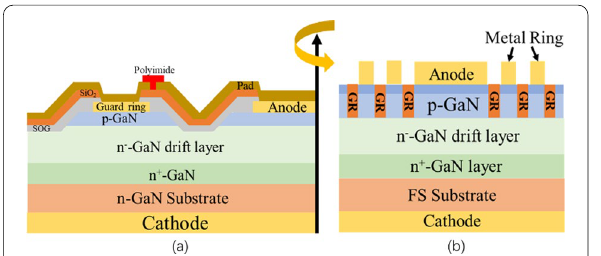
Fig. 9 a Vertical GaN PNDs structure with floating GR termination; b PNDs structure with H‑implanted GRs [69, 90]